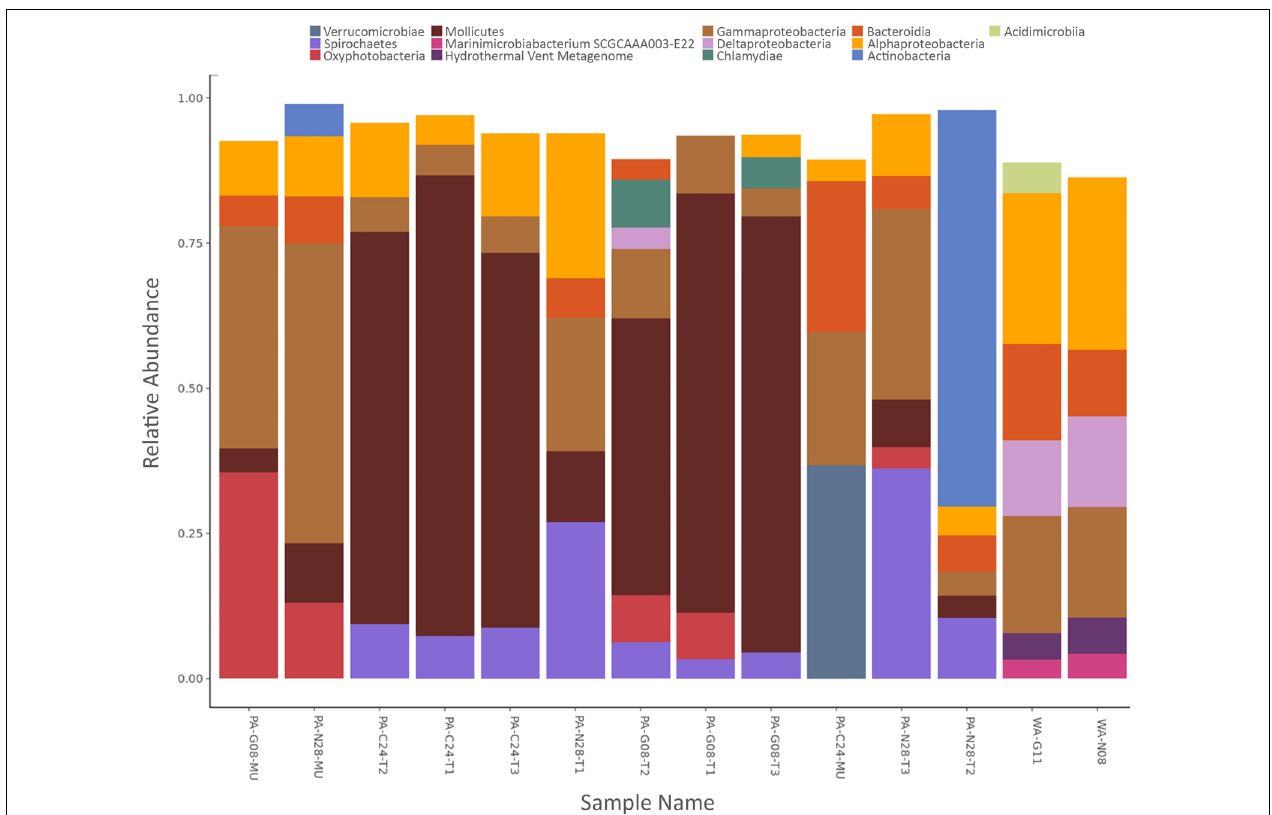
FIGURE 4 | Relative abundance of bacterial classes. X -axis represents samples of Paragorgia arborea tissue and mucus, and seawater. Y -axis represents the most dominant bacterial classes found within samples, with taxa contributing < 3% relative abundance